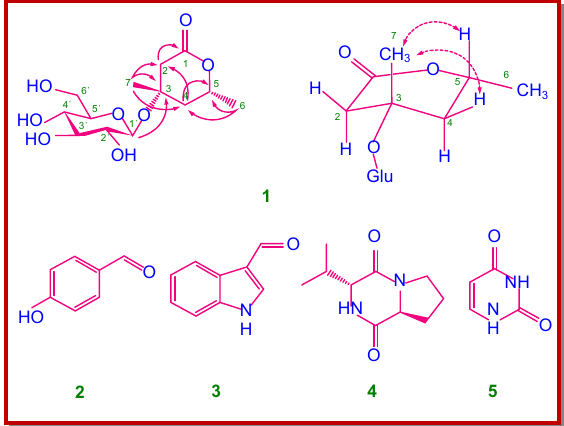
Figure 1: Structure of the compounds 1-5 and key HMBC (→) and NOESY (<--->) correlations of